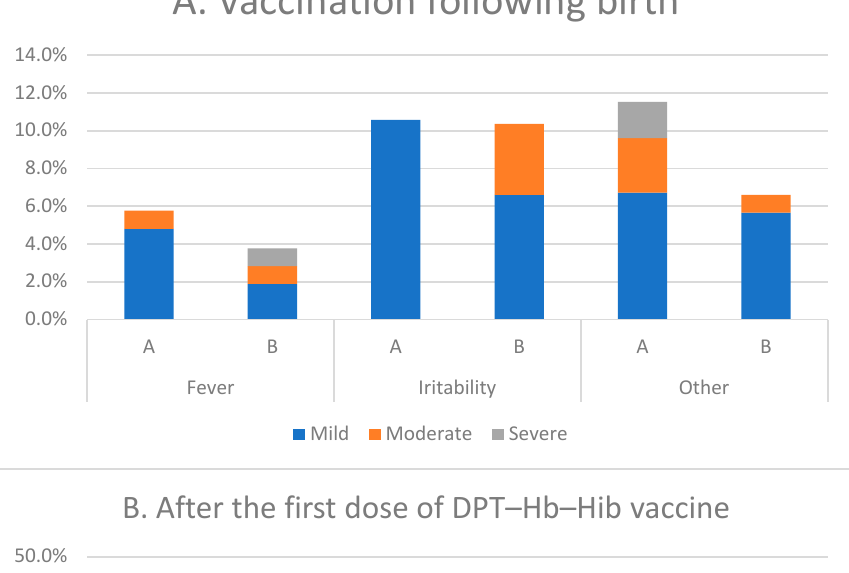
Figure 2. Local reaction.